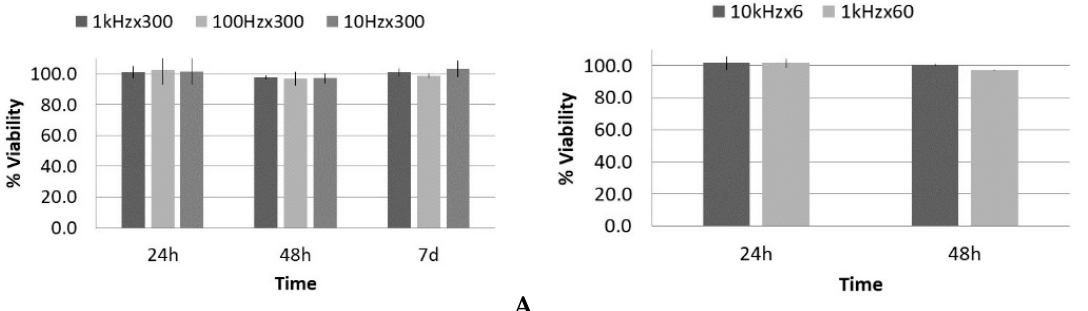
Figure 8. Viability (%), with respect to the control, 24 h, 48 h, and 7 d after treatment of fibroblasts with the short pulse protocol: ( A ) groups with the same total time of sonication (300 s) and ( B ) groups with the same total energy (60,000 pulses).